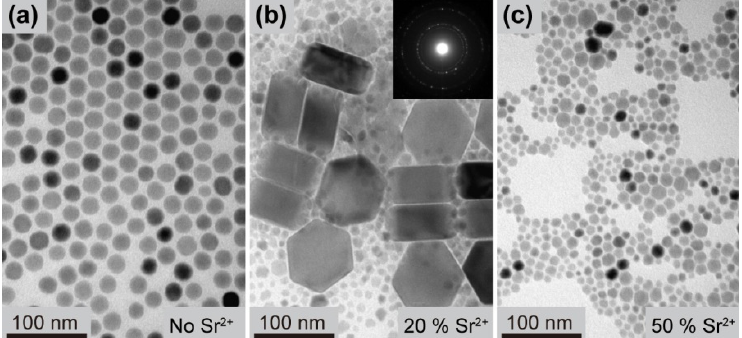
Figure 3. Transmission electron microscopy (TEM) images of the NaYF (18/2 mol %) nanoparticles obtained in the presence of ( a ) 0 mol %, ( b ) 20 mol %, and ( c ) 50 mol % of Sr 2+ dopant ions, respectively.